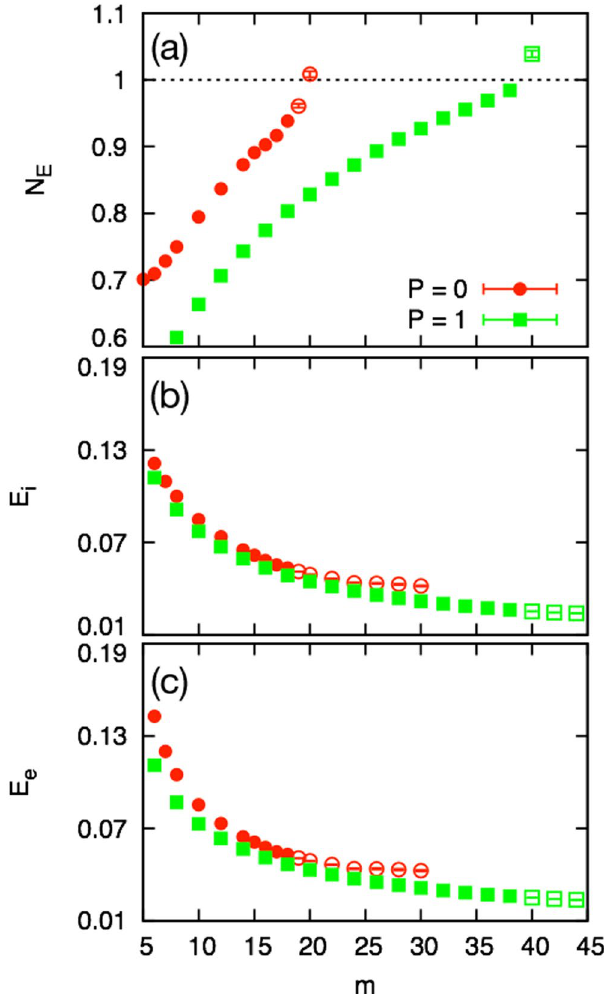
Figure 3. The mean-field approximation predictions of the transition points. ( a ) Estimation of the transition point from the diverging phase to the finite phase. The average number of total extinctions, = N EP 0 (circles) and = N EP 1 (boxes), increases monotonically as a function of m . They cross the critical value 1 at m * = 19.5 for the unidirectional model and at 2 M * = 39 for the bidirectional model. Both of m * and 2 M * agree well with the real transition points = . = m 18 5 CP 0 and = = M 2 39 CP 1 . ( b ) Extinction probability E i . ( c ) Extinction probability E e . For the unidirectional model (circles) and the bidirectional model (boxes) with the same unidirectional link degree of a newly incoming species m , the extinction probabilities E i and E e of the bidirectional model are smaller than the corresponding probabilities of the unidirectional